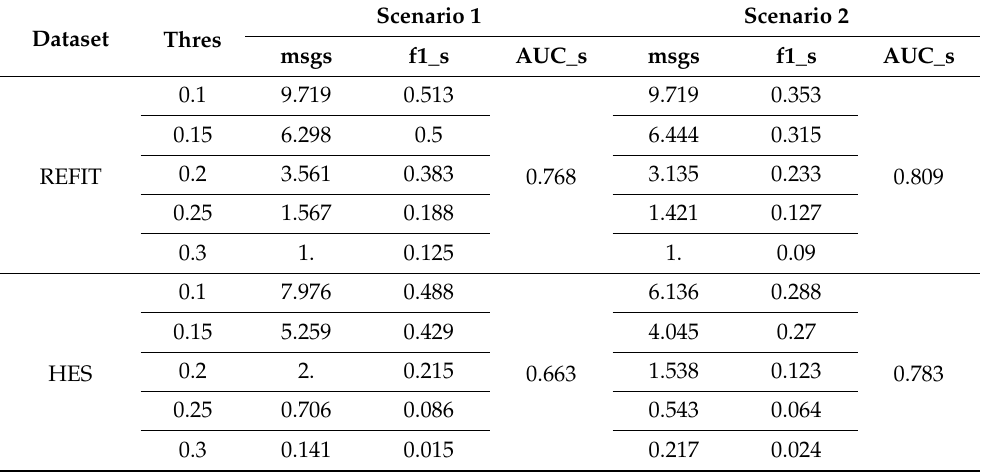
Table 7. Multi-appliance